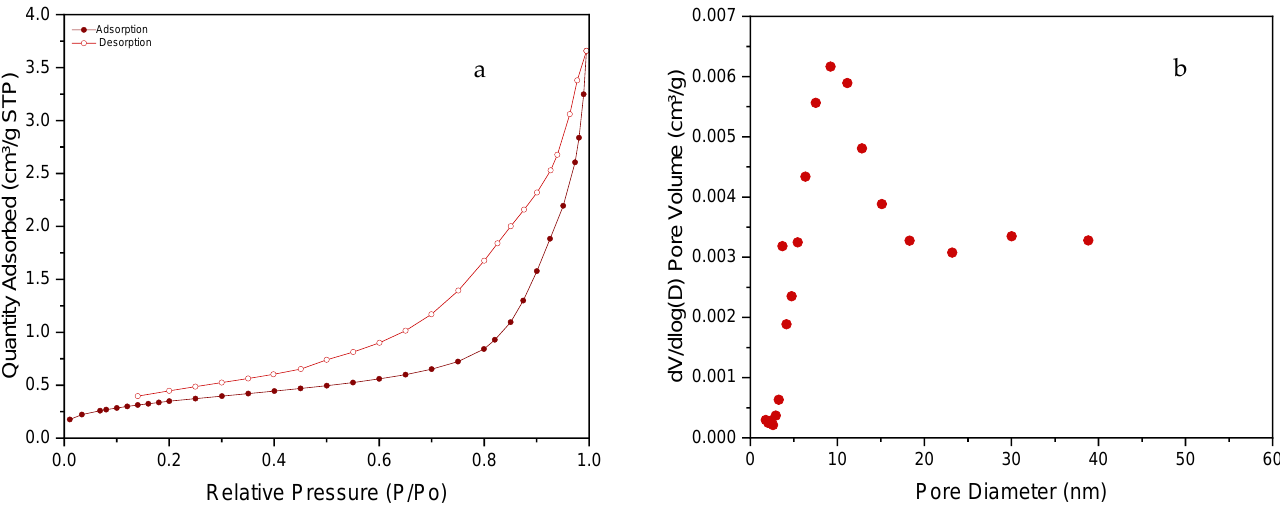
Figure 5. ( a ) Nitrogen adsorption-desorption isotherms of the SiC foam. ( b ) Pore size distribution of the SiC foam (BJH method desorption branch).